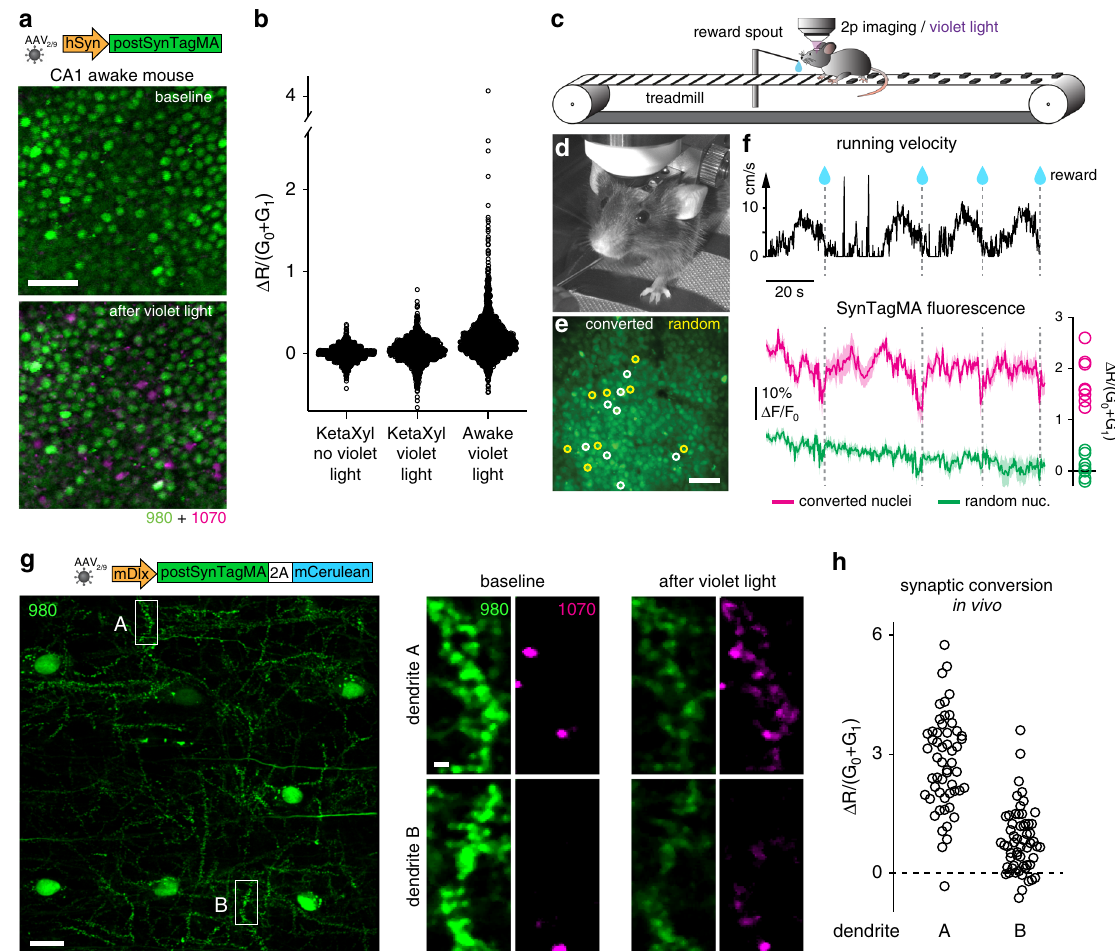
Fig. 7 SynTagMA identi fi es active neurons during behavior. a Nuclei of CA1 neurons expressing AAV2/9-hSyn-postSynTagMA imaged in vivo through a chronic cranial window using 980 nm and 1070 nm to excite green and red SynTagMA fl uorescence, respectively. Ten 2 s, 405 nm, 12.1 mW mm − 2 light pulses were applied in an awake mouse after which a small percentage of nuclei became photoconverted (magenta). b Photoconversion relative to baseline under ketamine-xylazine anesthesia ( n = 1105 nuclei), after violet light ( n = 1105 nuclei) and under awake conditions ( n = 1576 nuclei). c Closed loop paradigm: a head- fi xed mouse was trained to stop at a certain position on the running belt to receive a water reward (teardrop). Nuclear fl uorescence in CA1 was continuously monitored during 4 laps, followed by 15 laps where 405 nm, 12.1 mW mm − 2 , 2 s light pulses were triggered during water reward. d Mouse engaged in the task. Note spout for water delivery. e 2P image of CA1 cell body layer during running. Eight nuclei that later became photoconverted are marked by white circles. Yellow circles are eight randomly selected non-converted nuclei used for comparison of calcium signals. f Black trace is running speed during the fi rst 4 laps with times of reward delivery (teardrop/dashed line). Magenta and green traces are the average green SynTagMA fl uorescence of the 8 photoconverted nuclei and the 8 non-converted nuclei indicated in e , respectively. At right is the photoconversion of the individual nuclei. Note the consistent dips in the magenta trace (i.e., high calcium) just before the water reward/photoconversion light would be triggered. g Interneurons expressing AAV2/9-mDlx-postSynTagMA-2A-mCerulean imaged through a chronic cranial window under iso fl urane anesthesia (mCerulean fl uorescence not shown). At high magni fi cation, green fl uorescence reveals PSD spots on the dendrite. Red spots at baseline are auto fl uorescent material, unrelated to SynTagMA. Violet light (20 fl ashes, 0.2 Hz, 3 s duration, 0.42mW mm − 2 ) was applied to photoconvert postSynTagMA. h Photoconversion of synapses on dendrite A ( n = 54 synapses) and B ( n = 58 synapses) indicate higher activity levels in dendrite A. Scale bars: 50 µ m ( a, e ); 20 µ m and 2 µ m ( g ). All experiments were performed in at least two mice and found to be